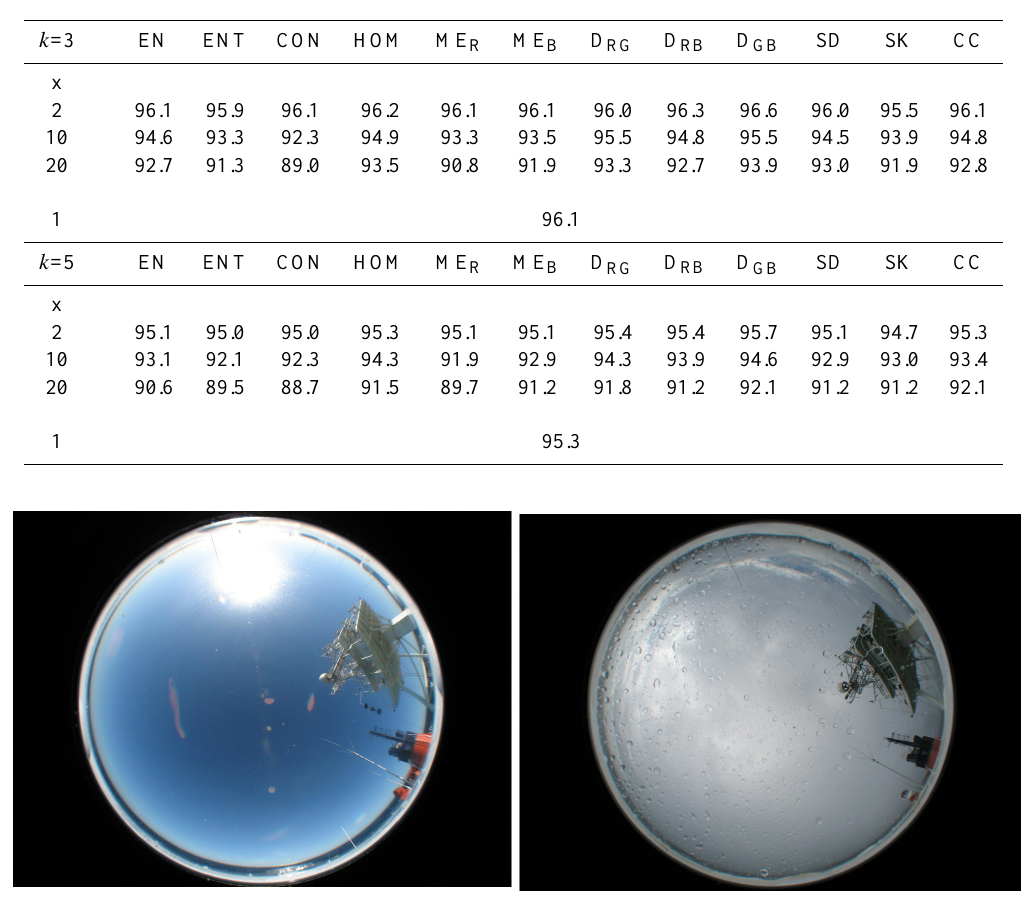
Table 3. Overall accuracy for k = 3 (top) and k = 5 (bottom) for the LOOCV using weighted features according to w y = ( 1 , 1 ,....,x,.., 1 ) in %. That means, feature y is weighted x times as often as the others.